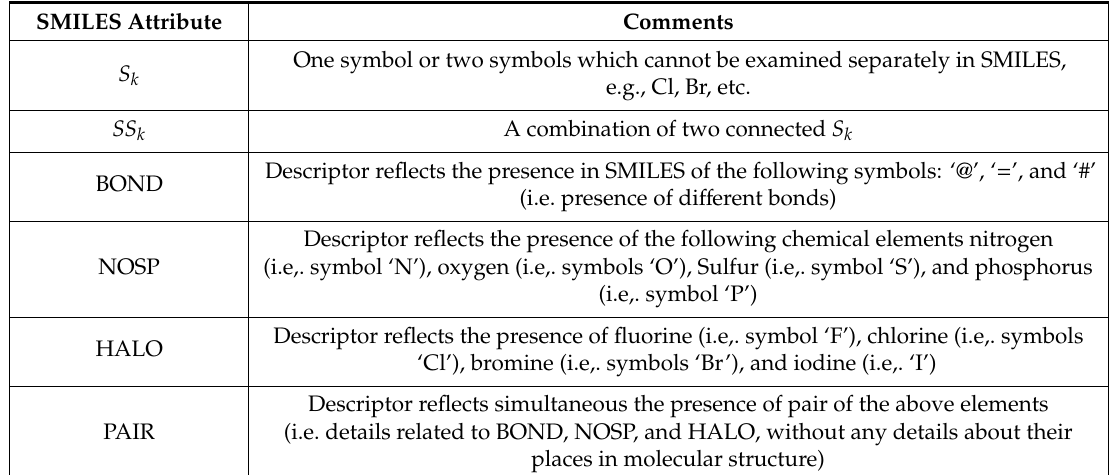
Table 4. Simplified molecular input-line entry system (SMILES) attributes applied to build up a model. SMILES